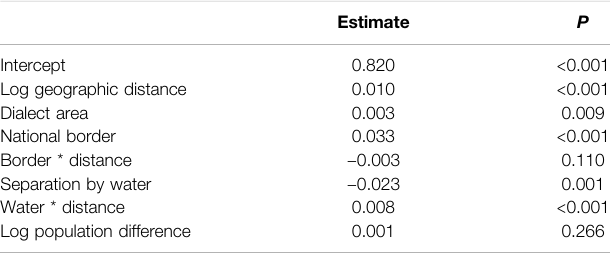
TABLE6| Multipleregressionoverdistancematrices(MRM)resultsforthe Church and religion